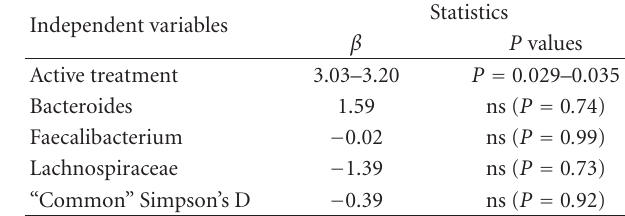
Table 3: Predictors for “treatment e ff ect” (increase in symptoms during active treatment minus increase during placebo